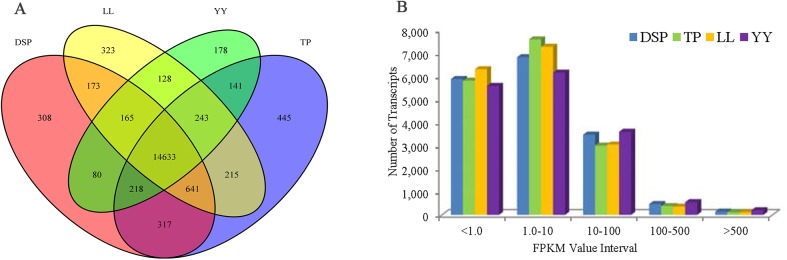
Summary of RNA sequence (RNA-Seq) mapping data.A: Venn diagrams of the number of genes expressed in each sample. B: The number of detected genes with different expression levels against the range of fragments per kilobase of exon length million mapped reads (FPKM) values.